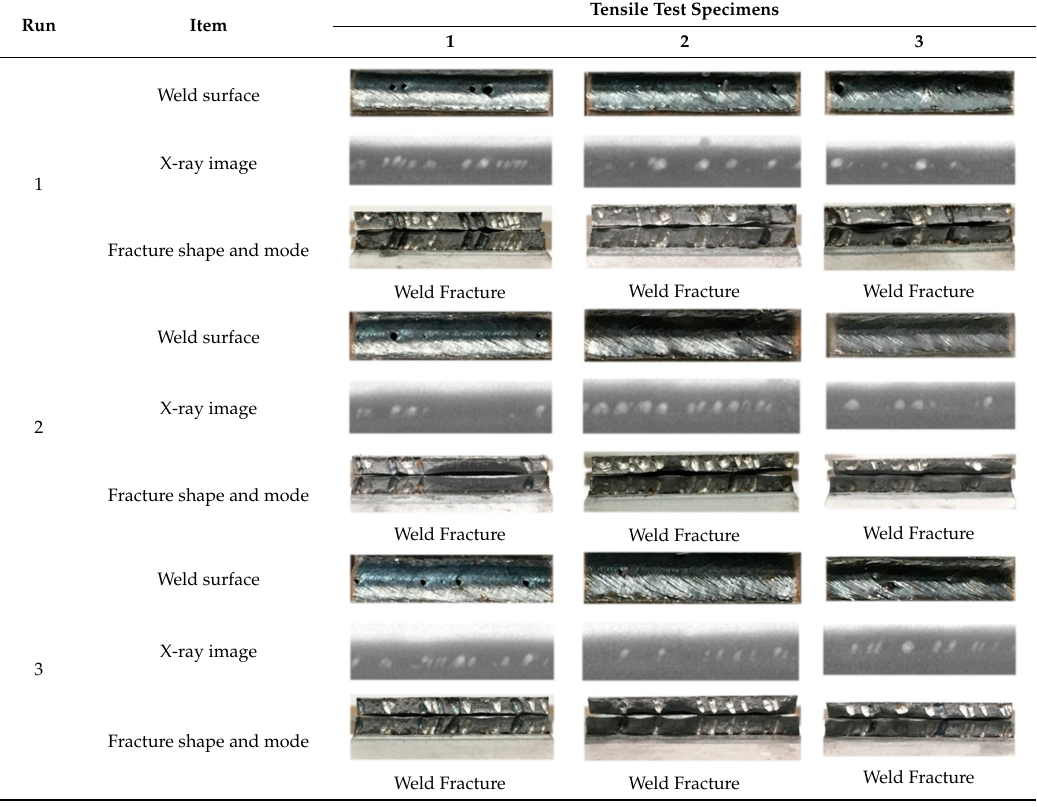
Table 4. Weld bead surface and fracture shape of each test specimen (gap: 0 mm).